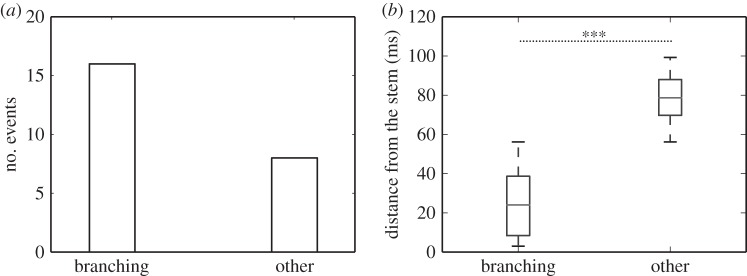
Characteristics of band formation. (a) Numbers of bands created by branching and other events before day 80. (b) Distance of new bands from the stem before day 80.